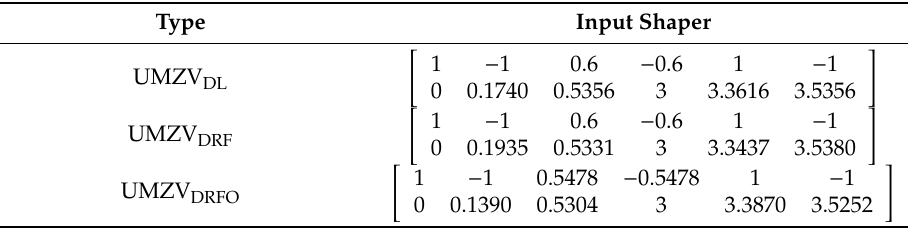
Table 2. Typical input shapers for start and stop motions.